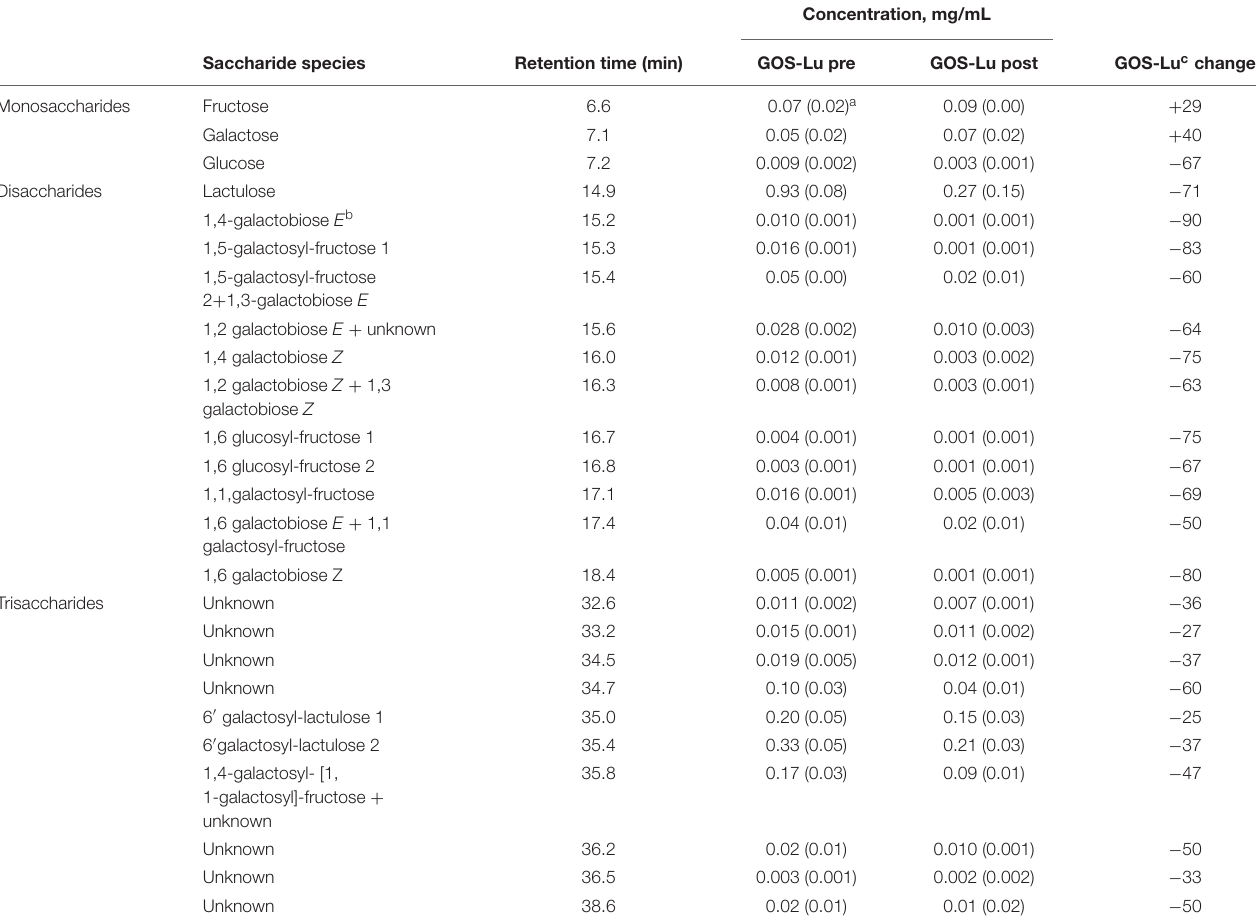
TABLE 5 | Quantification of GOS-Lu species before (Pre) and after (Post) incubation with B. pseudocatenulatum CECT